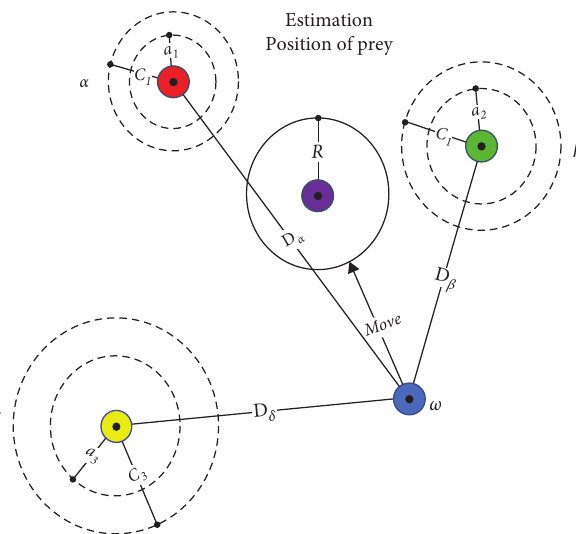
Figure 2: The position update process of the gray-wolf algorithm (Mirjalili et al., 2014).